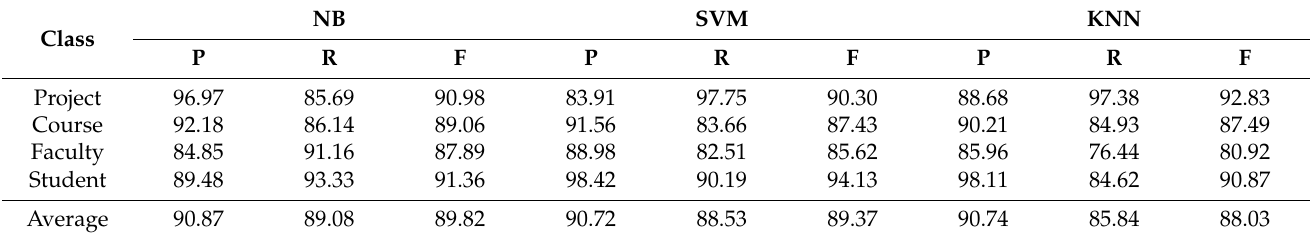
Table 12. Precision (P), Recall (R) and F-measure (F) of each class in the WebKB dataset using BBA LHS .